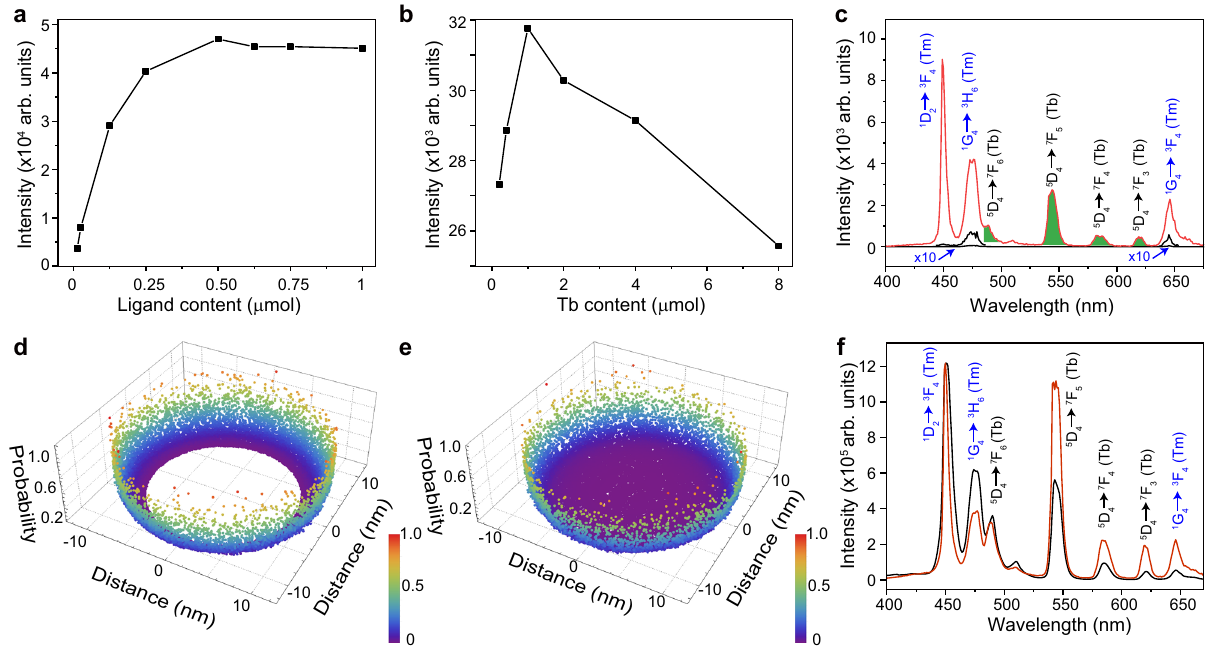
Fig. 2 Mechanistic investigation of the energy transfer process. a Intensity change in Tb 3 + emission at 546 nm versus the ligand (CPPOA) content. Samples were excited using a 980-nm laser. b Intensity change in Tb 3 + emission at 546 nm versus the Tb 3 + content used for cation exchange. Samples were excited using a 980-nm laser. c Upconversion luminescence spectra of CPPOA-modi fi ed NaYF 4 @NaYbF 4 :1%Tm@NaYF 4 :Tb nanocrystals (red) and NaGdF4:Yb/Tm(49/1 mol%)@NaGdF 4 :Tb (black) obtained by cation exchange under 980-nm excitation (76 W/cm 2 ). Note that Tm 3 + emission (black curve) is enlarged by 10-fold for better visualization. d , e Monte-Carlo simulation of the excitation energy distribution plotted against the Tm 3 + − surface ligand distance, showing the probability of excitation energy transfer to surface-bound ligand acceptors in a given NaYF 4 @NaYbF 4 :1%Tm@NaYF 4 :Tb multilayer nanoparticle ( d ) and a NaYF 4 :Yb/Tm (30/0.5%)@NaYF 4 :Tb core-shell nanoparticle ( e ). f Room-temperature emission spectra of CPPOA- modi fi ed NaYF 4 @NaYbF 4 :Tm (1 mol%)@NaYF 4 :Tb (red) and NaYbF 4 :Tm (1 mol%)@NaYF 4 :Tb (black) nanocrystals recorded in ethanol under 980-nm excitation (507 W/cm 2